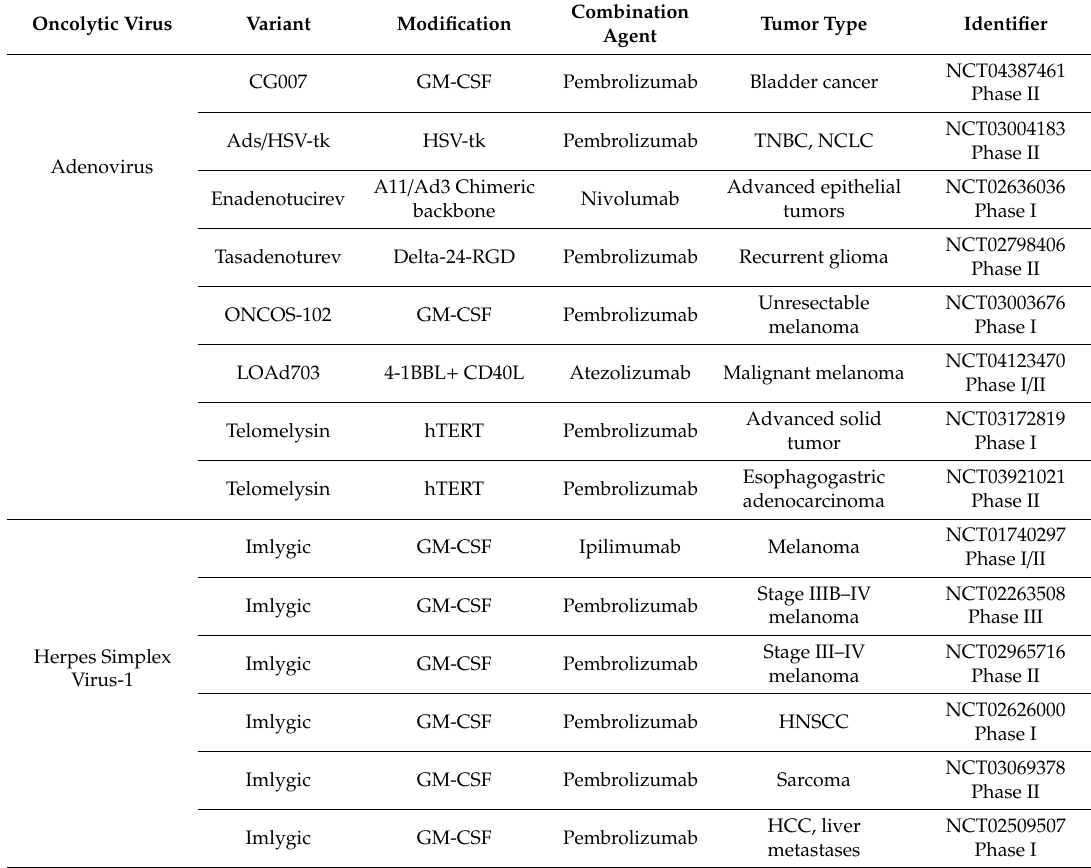
Table 1. List of ongoing combination therapy clinical trials with oncolytic viruses and immune checkpoint